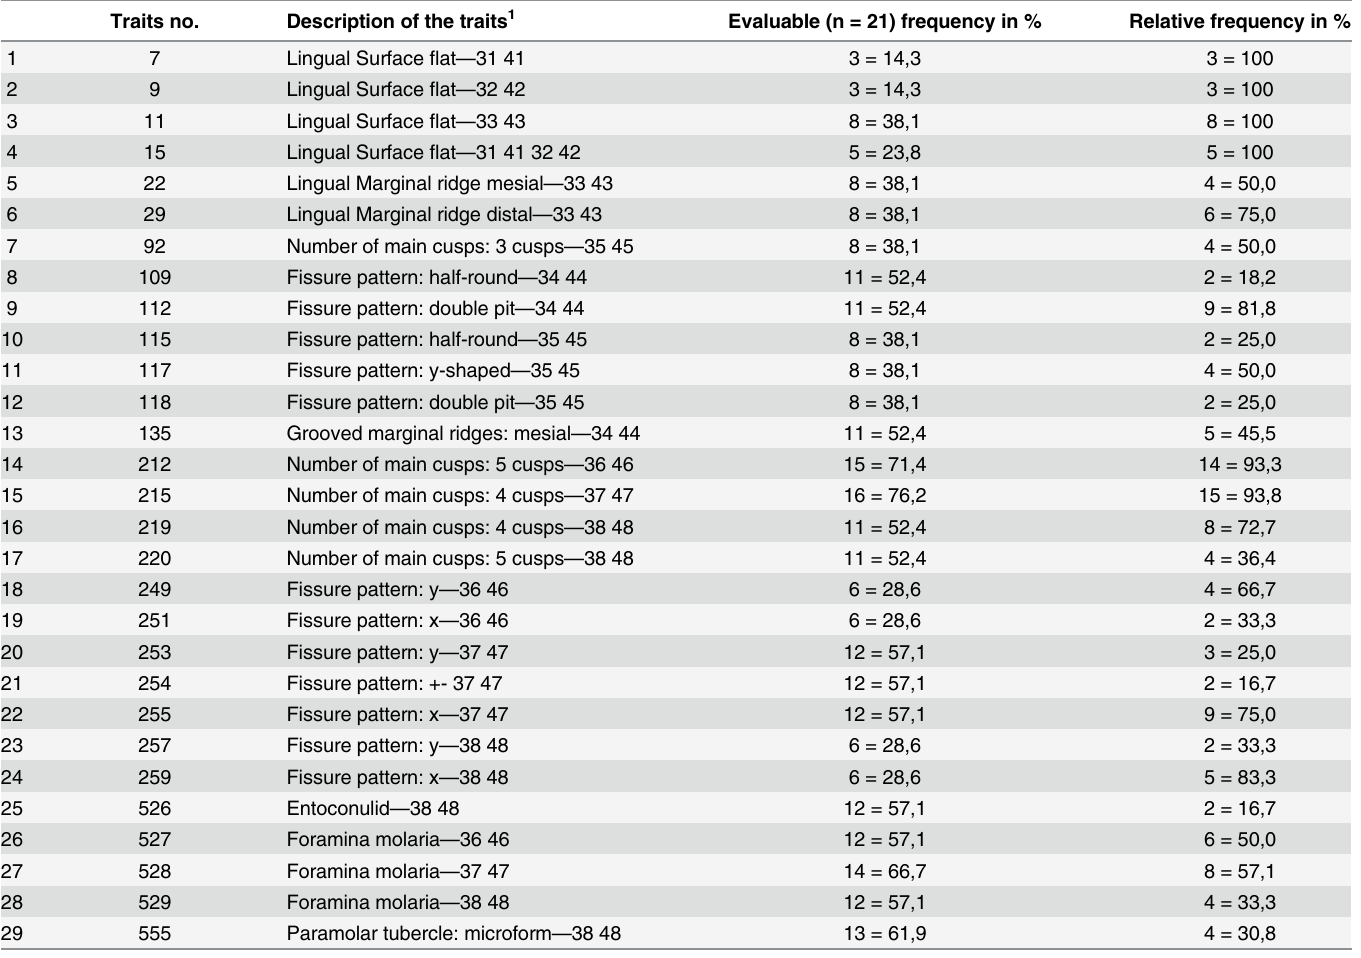
Table 2. List of traits evaluated for the analyses of biological relationship on teeth from Kfar HaHoresh. Traits no.